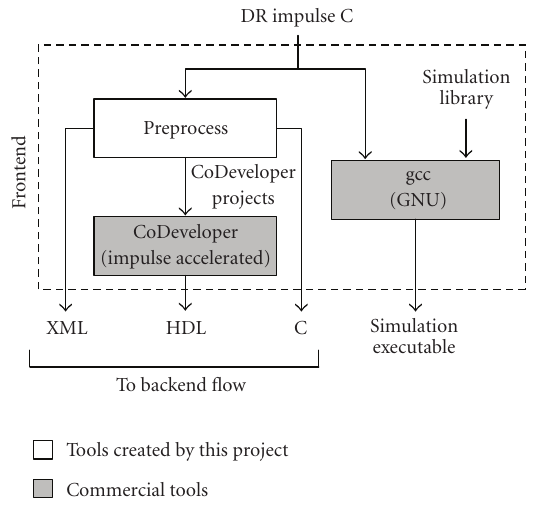
Figure 3: Frontend tool flow.